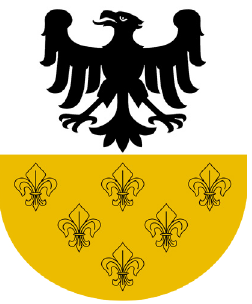
Figure 17. The former arms of